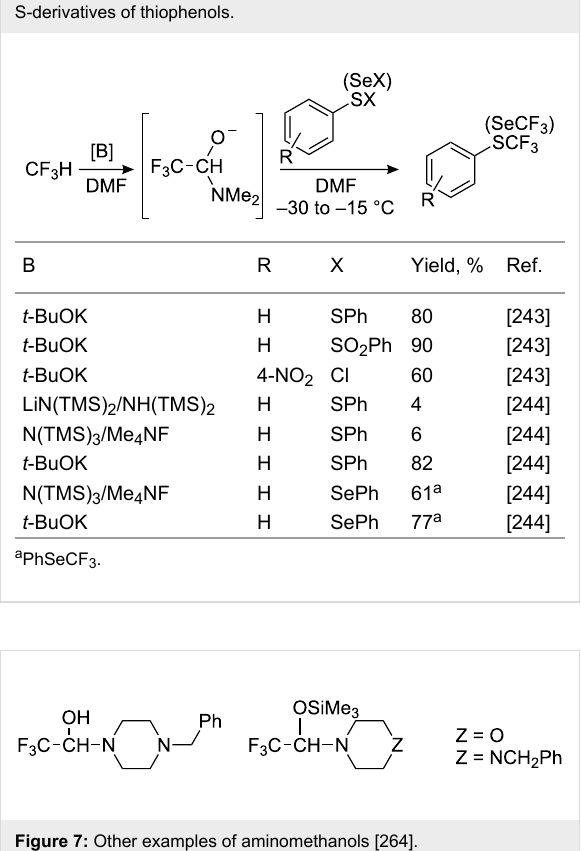
Table 15: Reaction of the CF 3 − anion derived from fluoroform with S-derivatives of thiophenols.